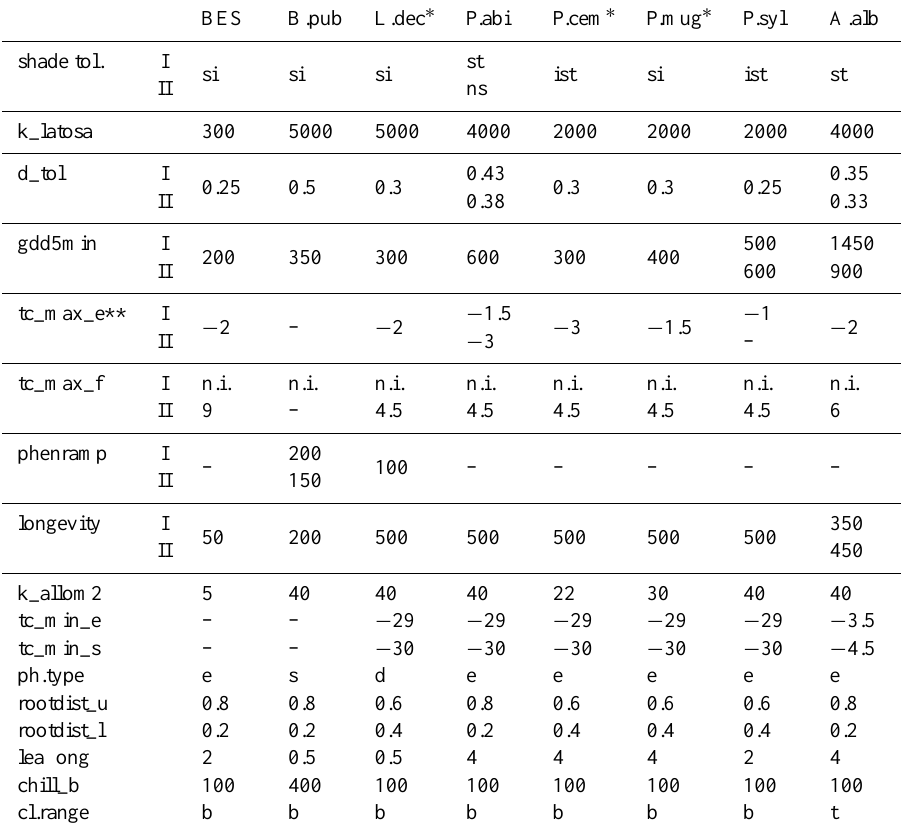
Table D10. Specific tree parameters of I the standard and II the adjusted parameter set. One entry per species and parameter means the same parameters were used for both sets or that the species was not included in the standard parameter set (newly added species). * newly added species; ** direct comparison between I and II not meaningful because different establishment functions were used; n.i.: parameter not implemented. b: boreal; t: temperate; st: shade tolerant; ns: nearly shade tolerant; ist: intermediate shade tolerant; si: shade intolerant; e: evergreen; s: summer-green; d: summer-green with decelerated senescence; cl.range: climatic range; shade tol.: shade tolerance; ph.type: phenology type; phenramp: growing degree sum on 5 ◦ C base required for full leaf cover; k_latosa: ratio of leaf area to sapwood cross- sectional area; rootdist_u and rootdist_l: proportion of fine roots extending into upper and lower soil layers; leaflong: leaf longevity; chill_b: changed chilling parameter (Sykes et al., 1996); d_tol: drought tolerance, lower values show higher tolerance (minimum soil water content needed for establishment, averaged over the growing season and expressed as a fraction of available water holding capacity, and